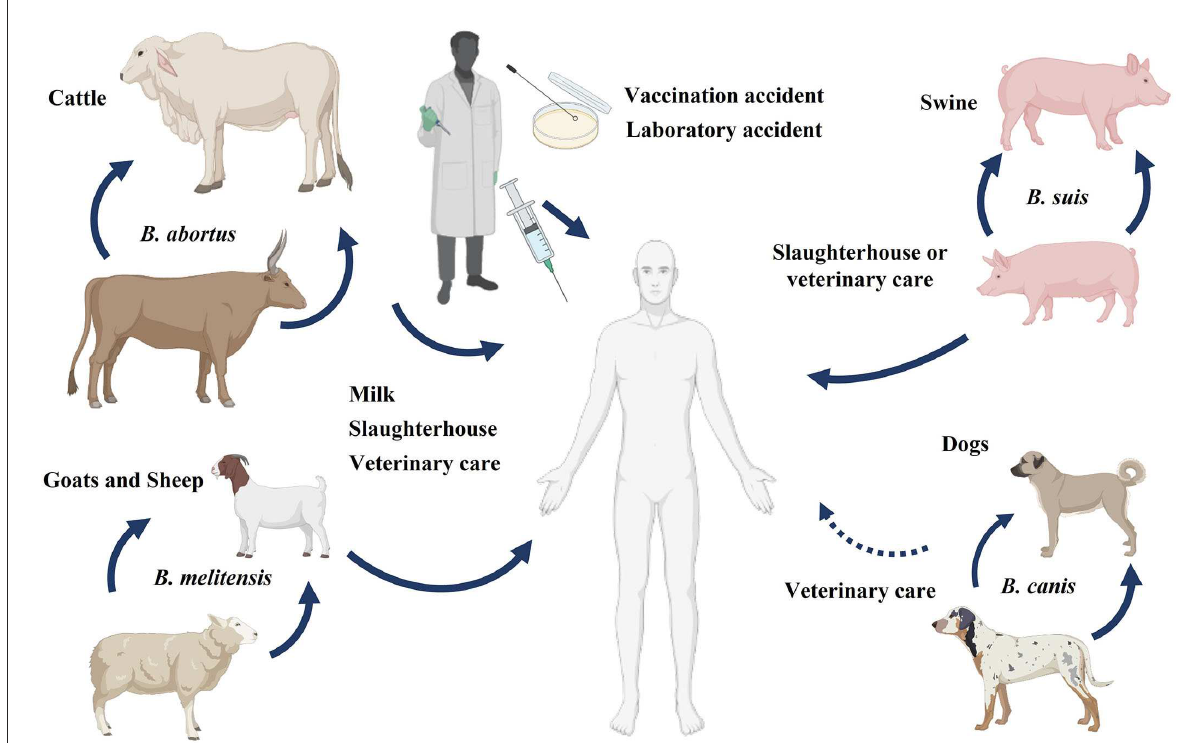
FIGURE10 Reservoir and transmission of Brucella . Brucellosis in humans can be transmitted from different animals like cattle, sheep, goats, swine, and rarely from dogs. The sources of disease transmission include consumption of unpasteurized milk and milk products, direct association with animals or animal products, and accidental laboratory exposure.